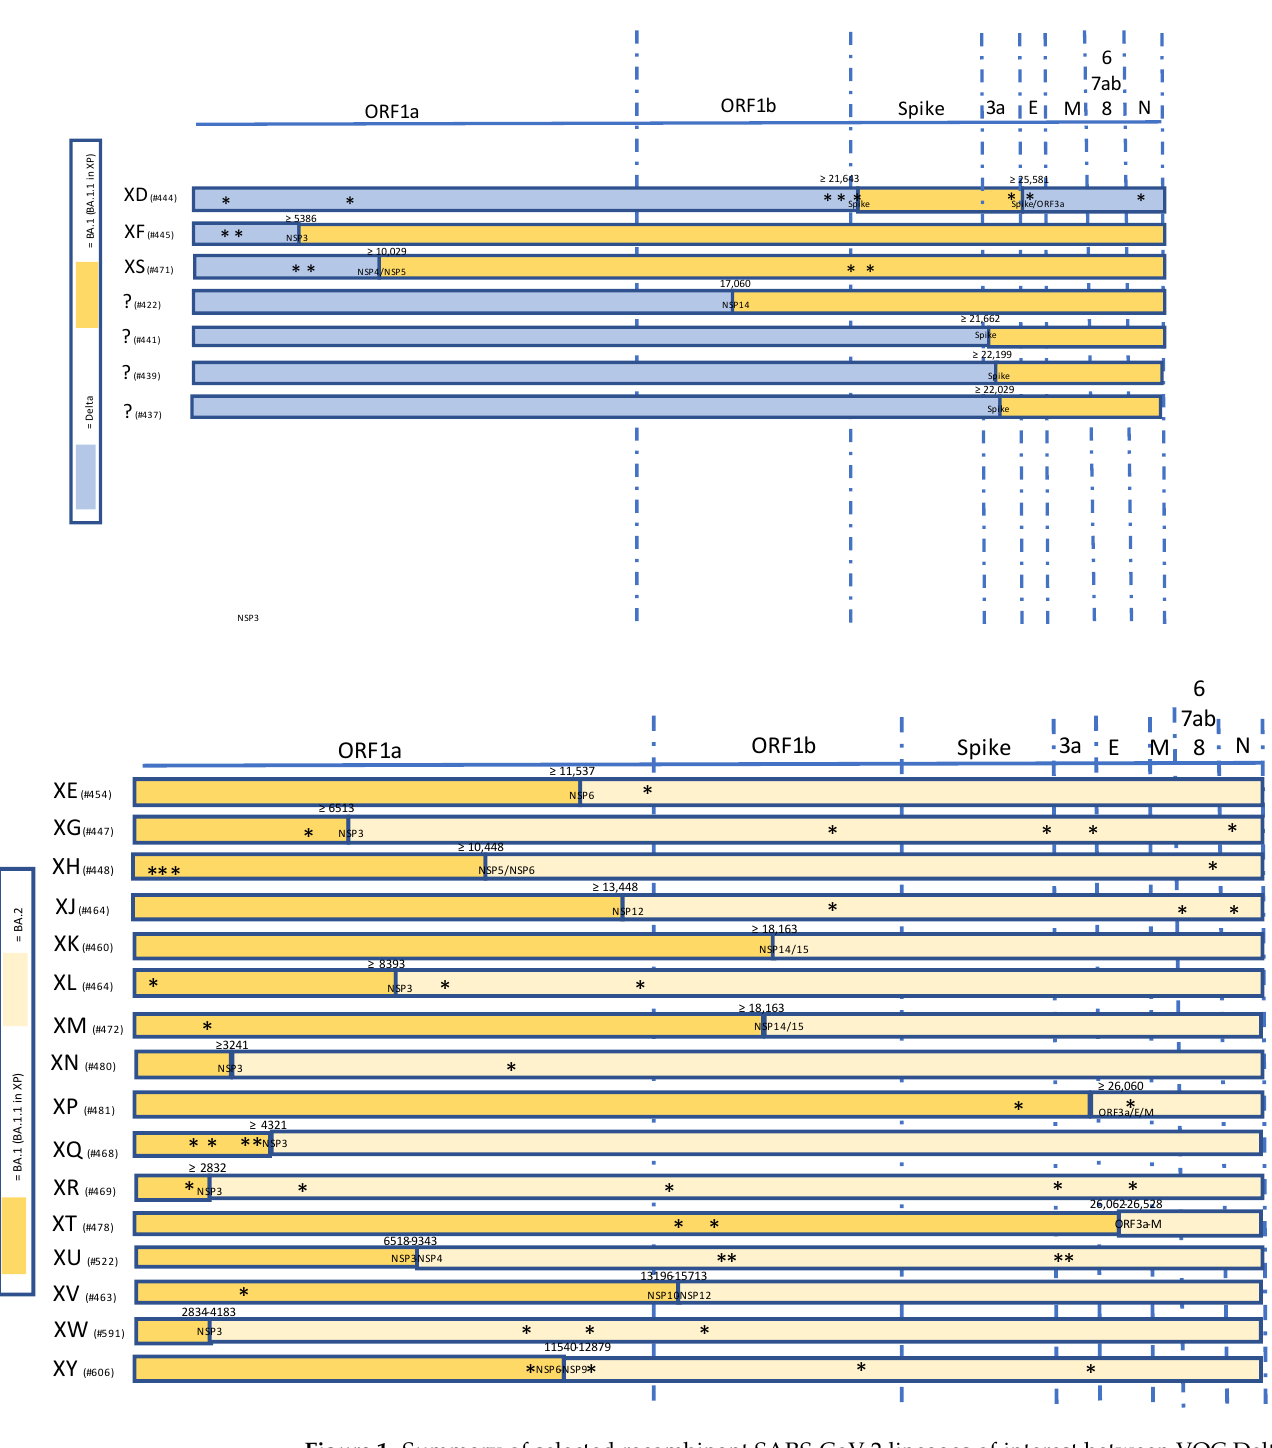
Figure 1. Summary of selected recombinant SARS-CoV-2 lineages of interest between VOC Delta and Omicron (upper panel) and within Omicron VOC sublineages (lower panel). Unlabeled private mutations are marked with *.